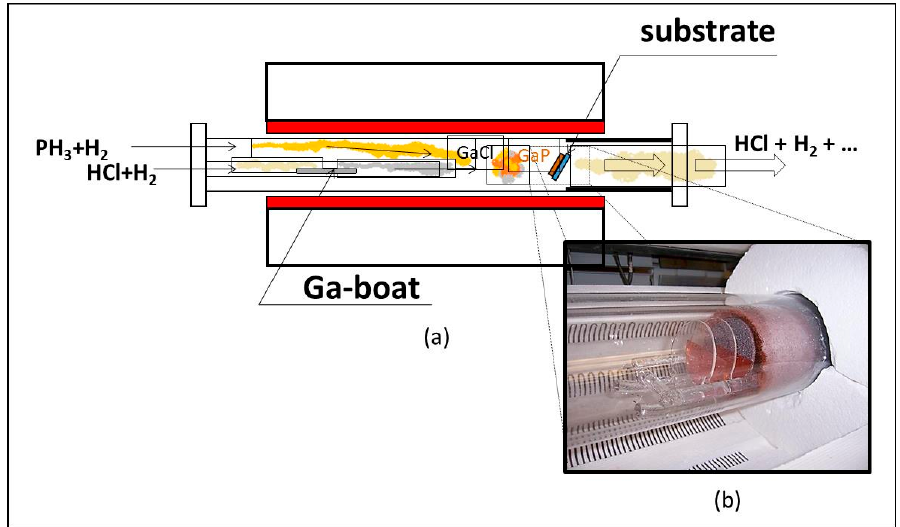
Figure 17. ( a ) HVPE growth of GaP in a low-pressure horizontal quartz reactor; ( b ) parasitic nucleation on the quartz tube, luckily in the area that is behind the substrate [63]. (Reproduced from [63] with the permission of